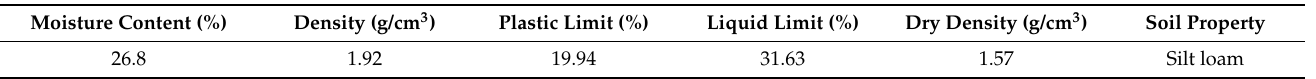
Table 2. Main technical parameters of experimental